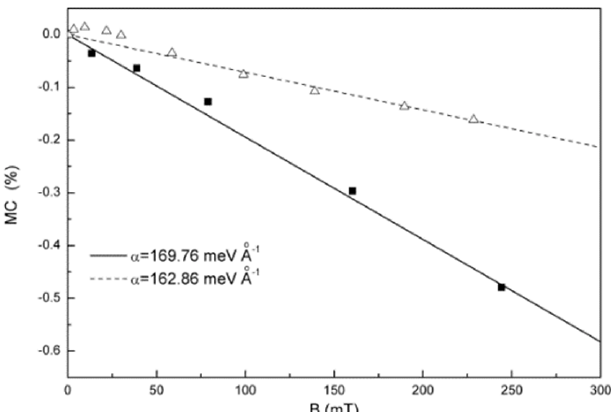
Figure 19. Change of magnetic conductance under different electron phonon coupling. Lines are the theoretical results by Li et al. [71] with the permission of Organic Electronics. Data for the block symbols are for PtOEP [72], and triangle symbols for Ir(ppy) 3 [73].